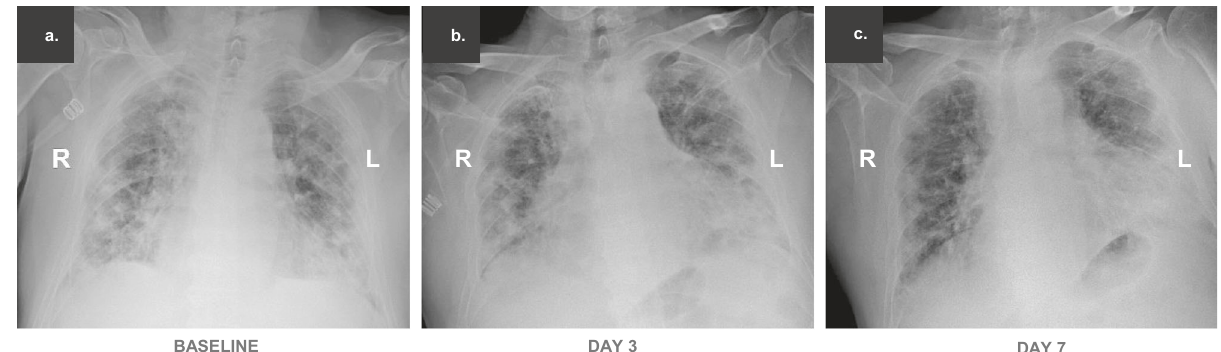
Fig. 5 Representative chest X-ray images. Chest X-ray images of an Italian patient with severe Covid-19 who received bevacizumab treatment at days 0 ( a ), 3 ( b ), and 7 ( c ) relative to the prior